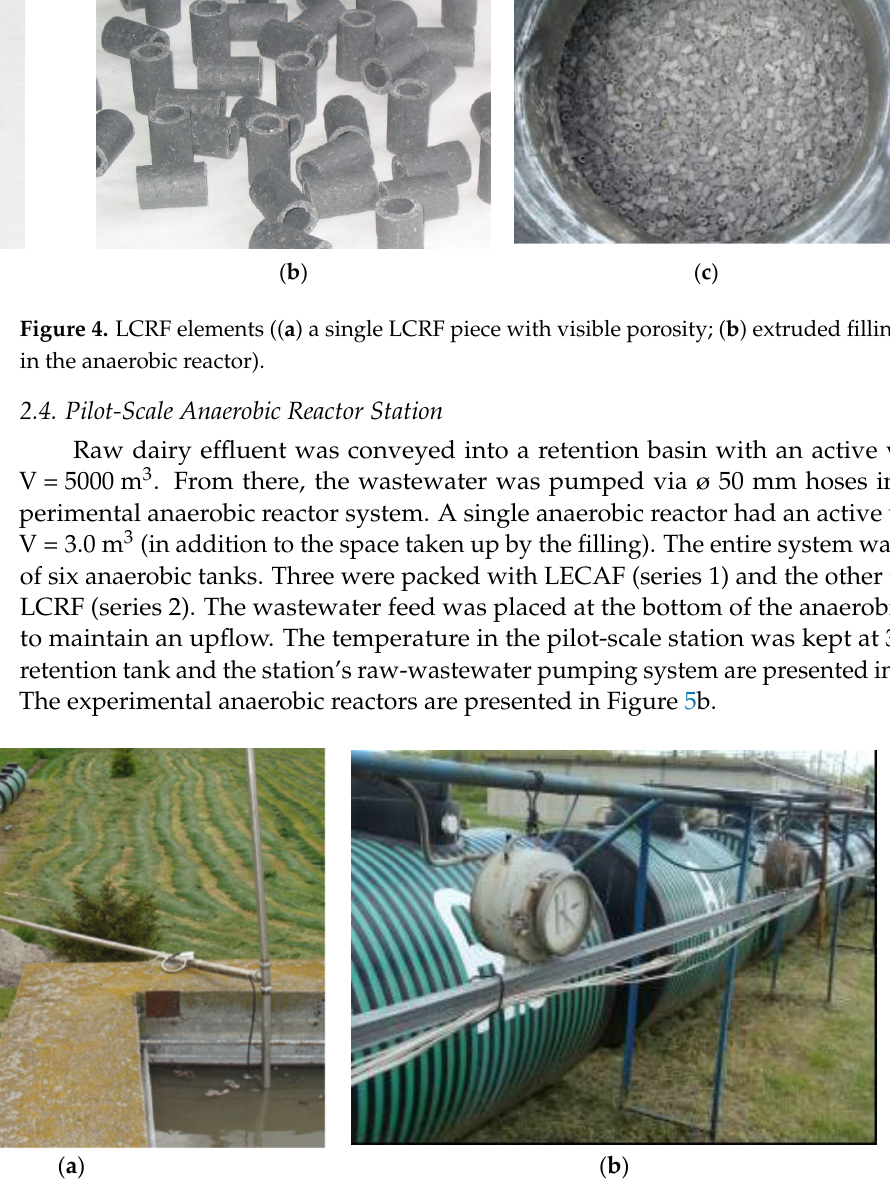
Figure 5. Anaerobic Reactor Station (( a ) retention basin with influent pumping system; ( b ) anaerobic reactors).